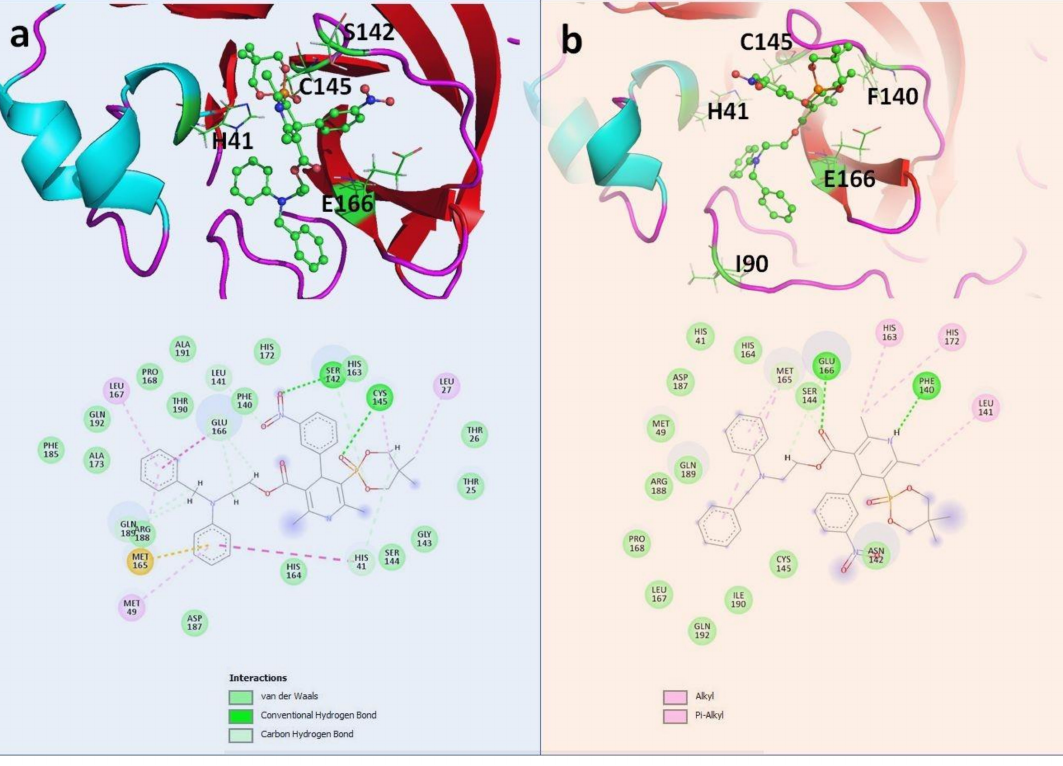
Figure 4. Complex of Efonidipine within the active site of ( a ) N142S; ( b )